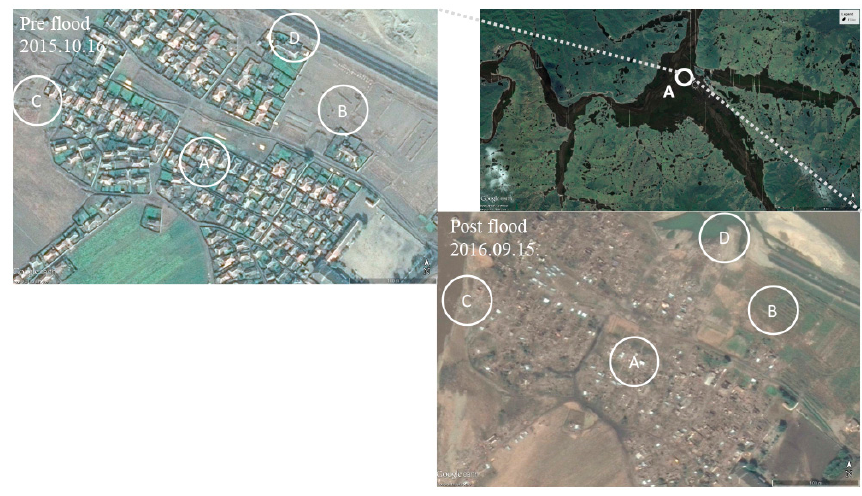
Figure 9. High-resolution Google Earth images of the study area.